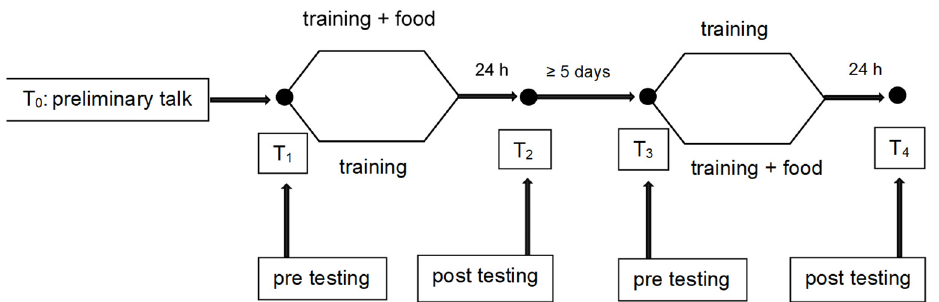
Figure 1. Cross-over design of